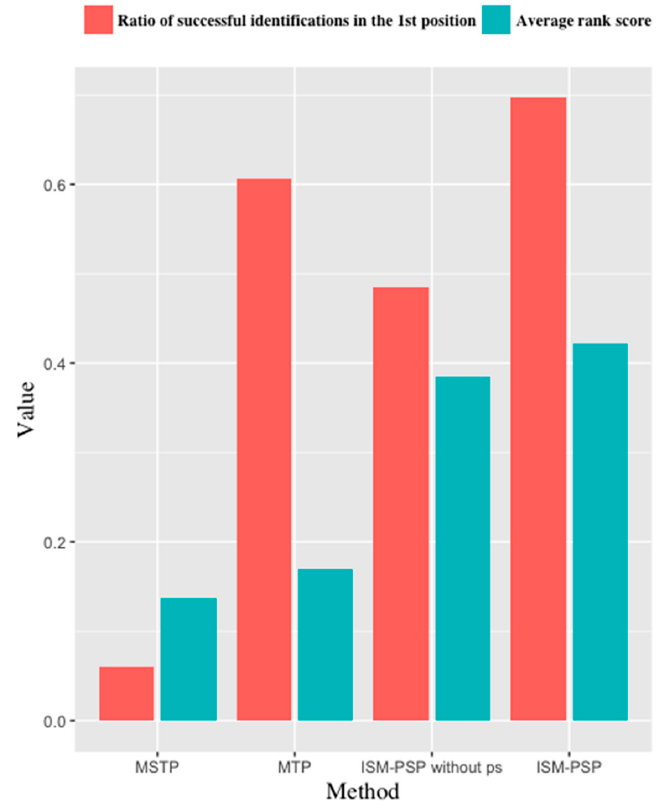
Figure 6. Ratio of identifying v i in the first position and average rank scores using different methods.